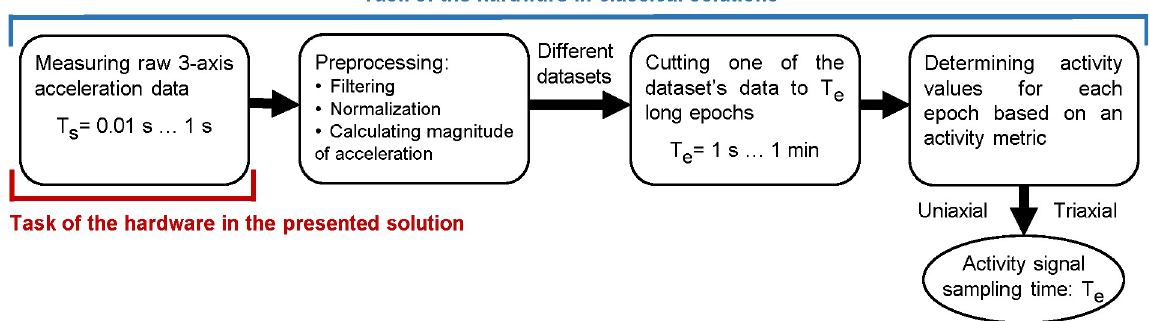
Fig 1. The general steps of determining activity values. The activity for a given T e epoch length calculated from the 3-axis acceleration data sampled with T s sampling